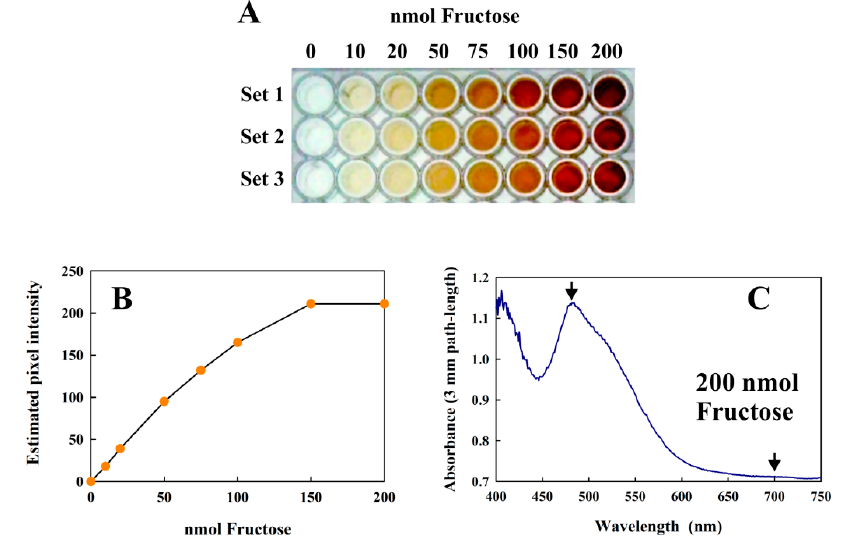
Figure 6. ( A ) The modified Kulka assay performed in 96-well plates using increasing amounts of fructose. Three replicates are shown (Sets 1–3) as a 24-bit color image. ( B ) Plot of the average pixel intensity from the center of each well in Set 1 of the RGB green channel 8-bit image (obtained from the 24-bit RGB image in ( A )) vs. the amount of fructose present. ( C ) shows the absorption spectrum obtained from 100 µL of the Set 1 well (centrifuged) reaction mix containing 200 nmol fructose using a diode array spectrometer. The arrows indicate the measured absorbances.